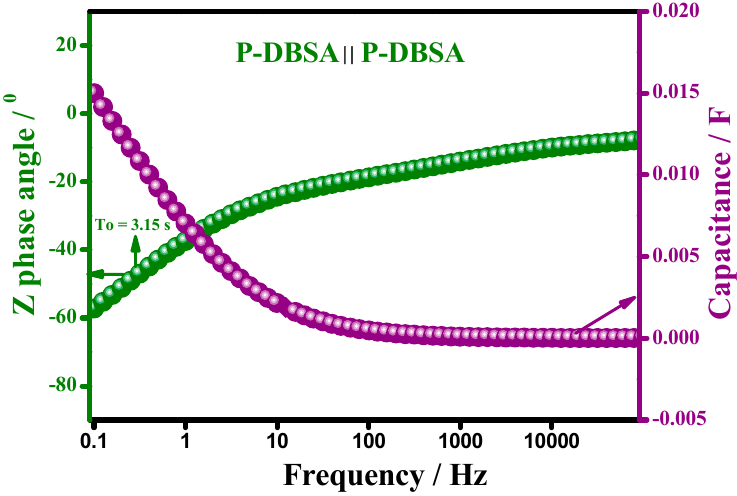
Figure 14. Variation of capacitance and the phase angle, with a change in frequency.